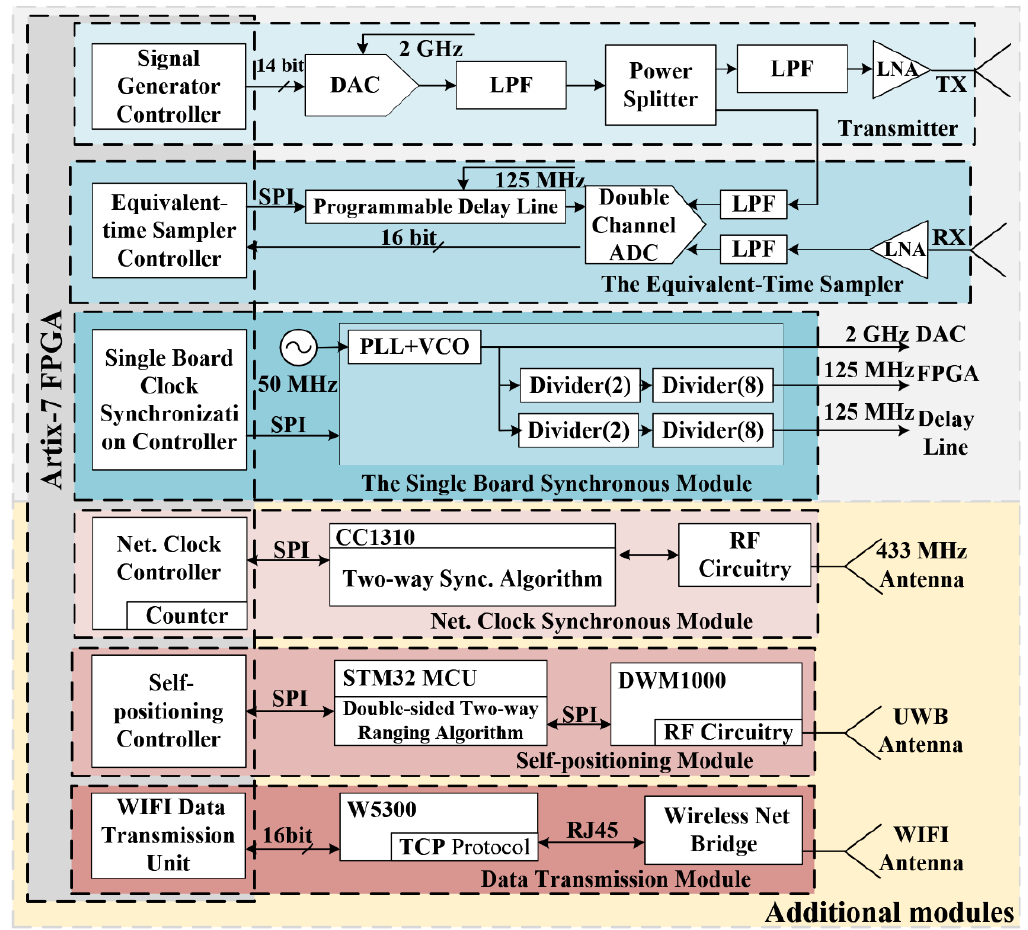
Appl. Sci. 2021 , 11 , x FOR PEER REVIEW Figure 1. The block diagram of the Golay-coded radar. Figure 1. The block diagram of the Golay-coded radar.